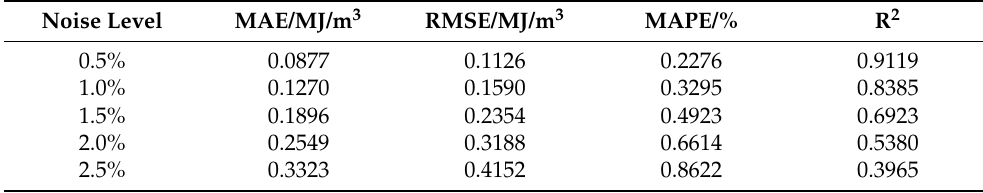
Table 6. Comparison for prediction performance under different noise levels.